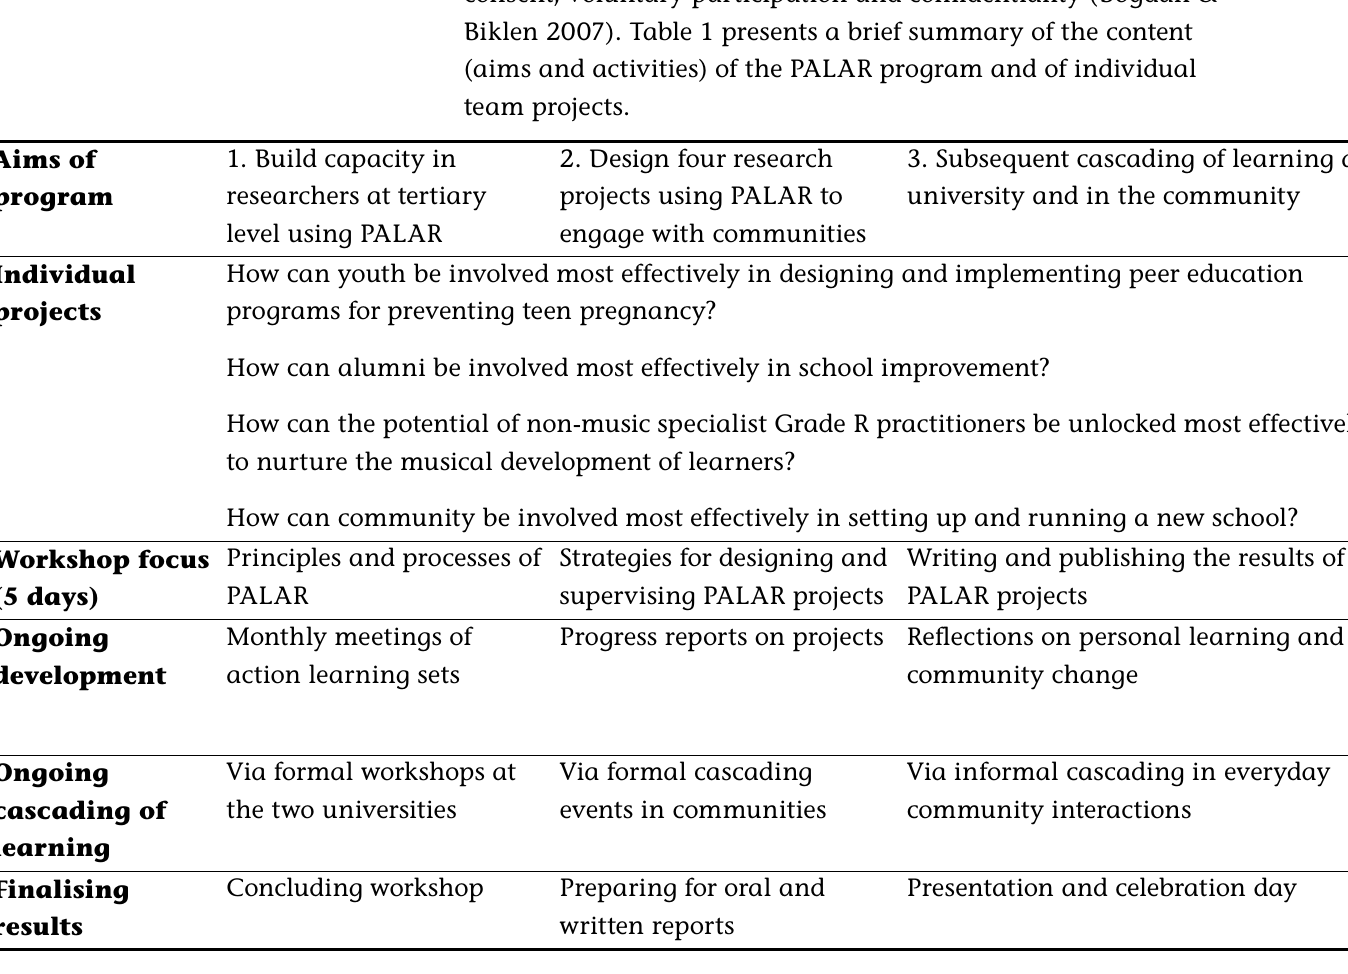
Table 1: Summary of aims, projects and program